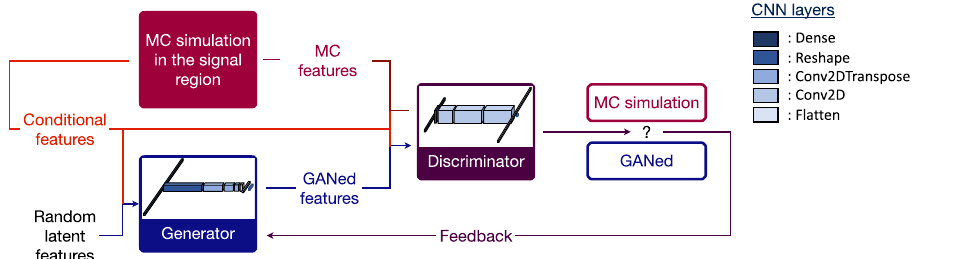
Fig. 1 Layout of the proposed conditional GAN architecture training. Conditional features and random latent features are given as inputs to the generator model. The generator model creates a new object with properties of a misidentified object of the SR. The discriminator model is expected to classify between MC-simulated events and GANed